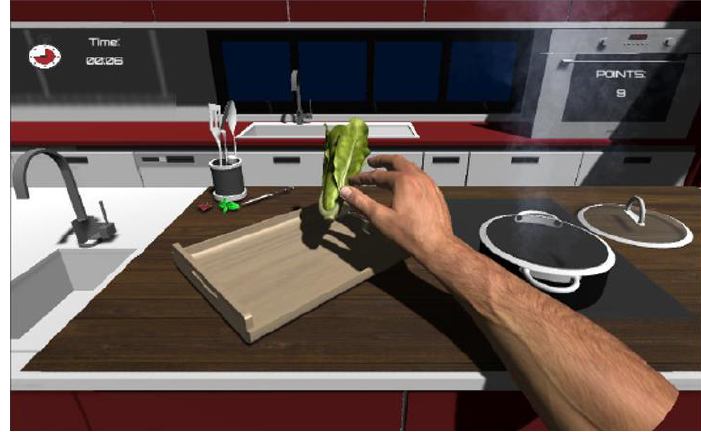
Figure 5. Collecting stars interface. One star has been